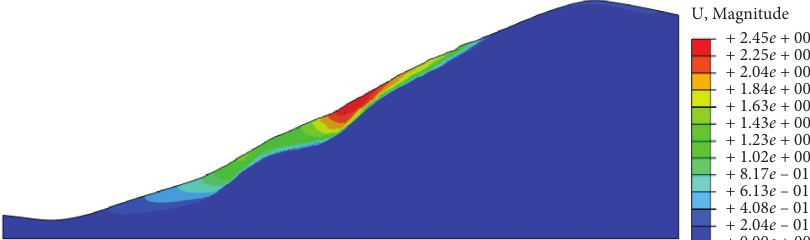
Figure 9: Cumulative equivalent displacement cloud map of the slope at the critical stress at t � 0.667 s.